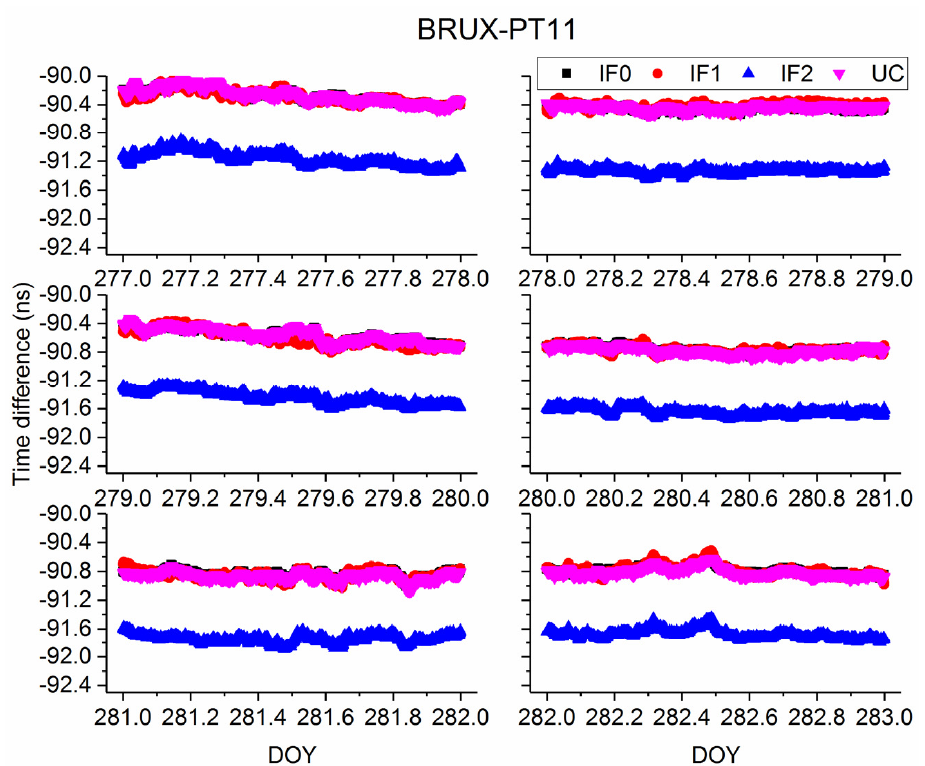
Figure 7. Comparison of time difference of BRUX-PT11 obtained from different models.